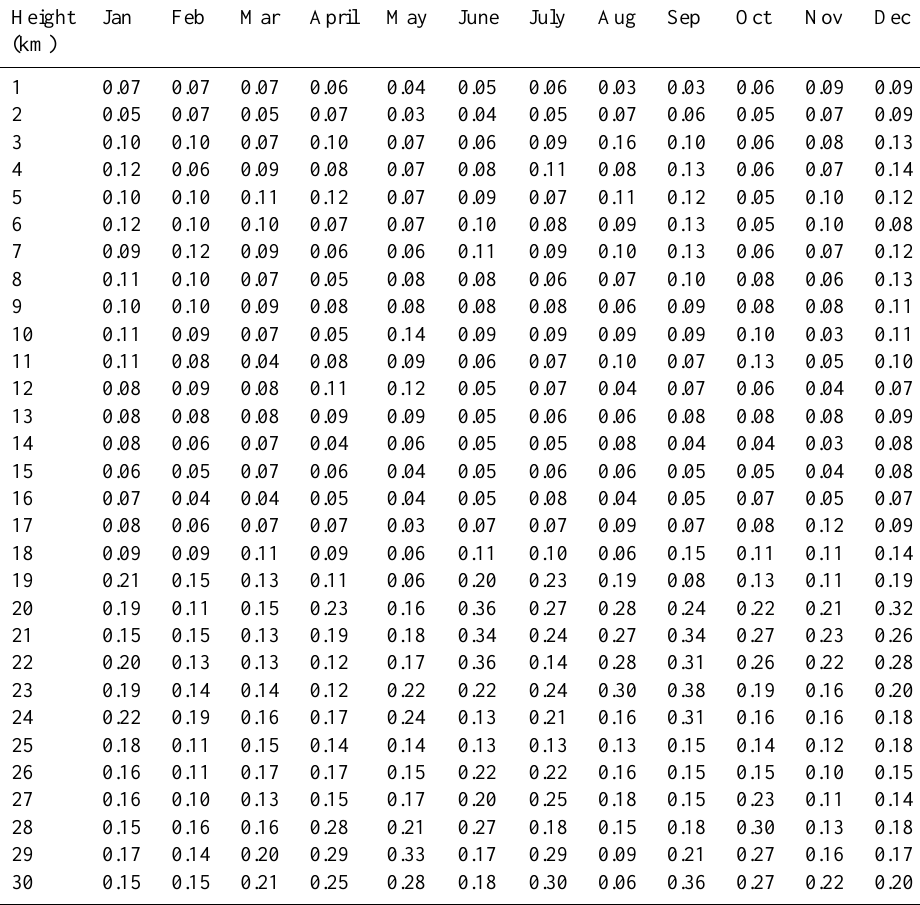
Table A2. (b) Standard deviation ( × 10 12 mol/cm 3